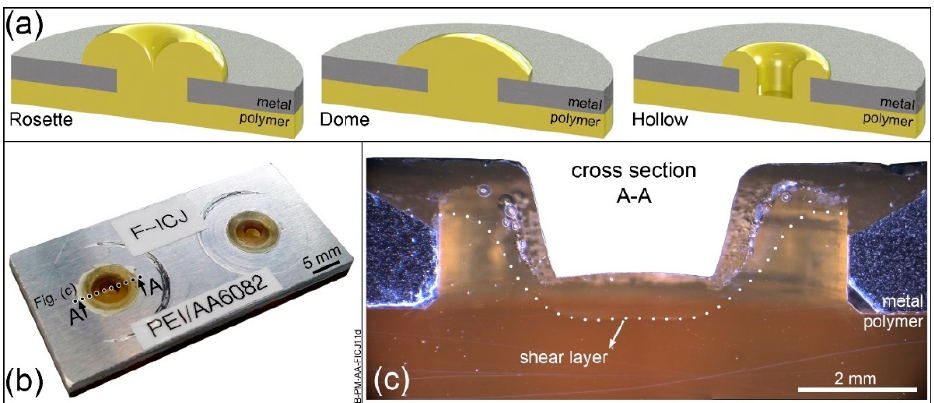
Figure 1. ( a ) Conventional stake designs for metal-polymer structures; ( b ) surface view of an F-ICJ structure; ( c ) cross-sectional view of an F-ICJ stake. Adapted from [19].